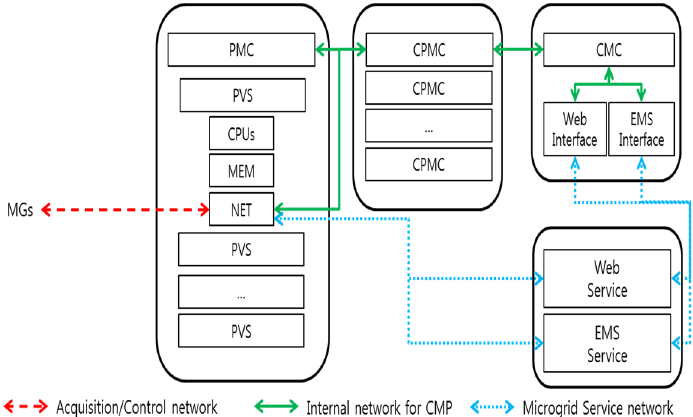
Figure 4. Proposed real-time architecture design.